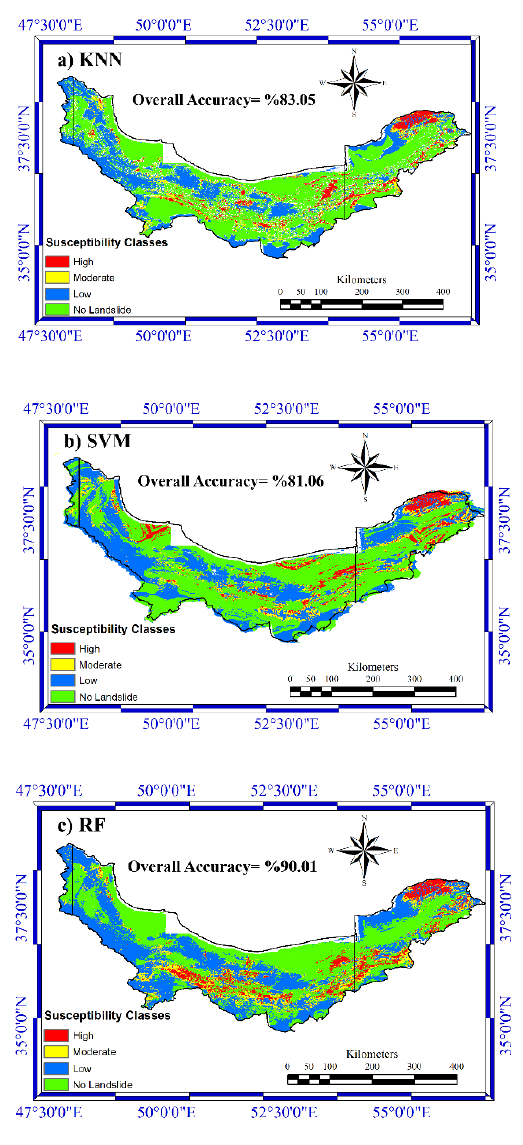
Figure 2. Landslide susceptibility maps generated using a) KNN b) SVM c) RF models based on GA optimization in